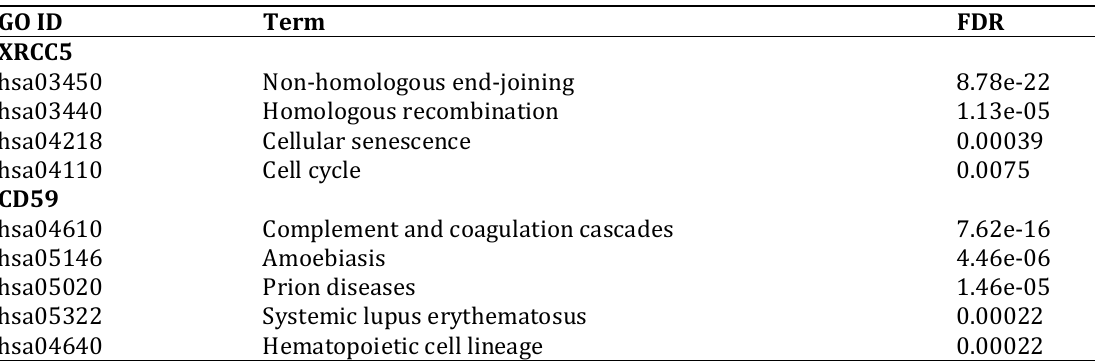
Table IV. KEGG pathway analysis of genes in the XRCC5 and CD59 interaction networks GO